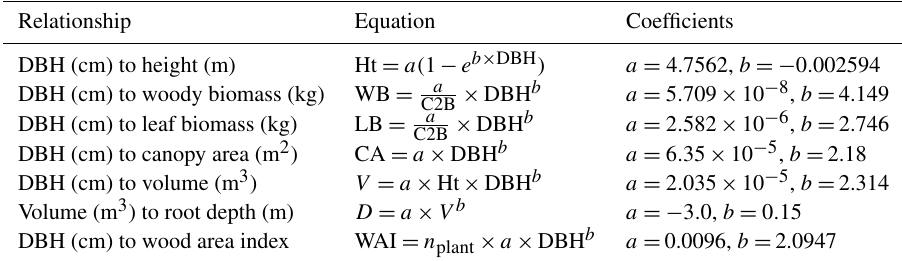
Table 2. Coefficients for sagebrush (shrub) PFT to allometric equations in EDv2.2 (temperate PFTs). Relationship